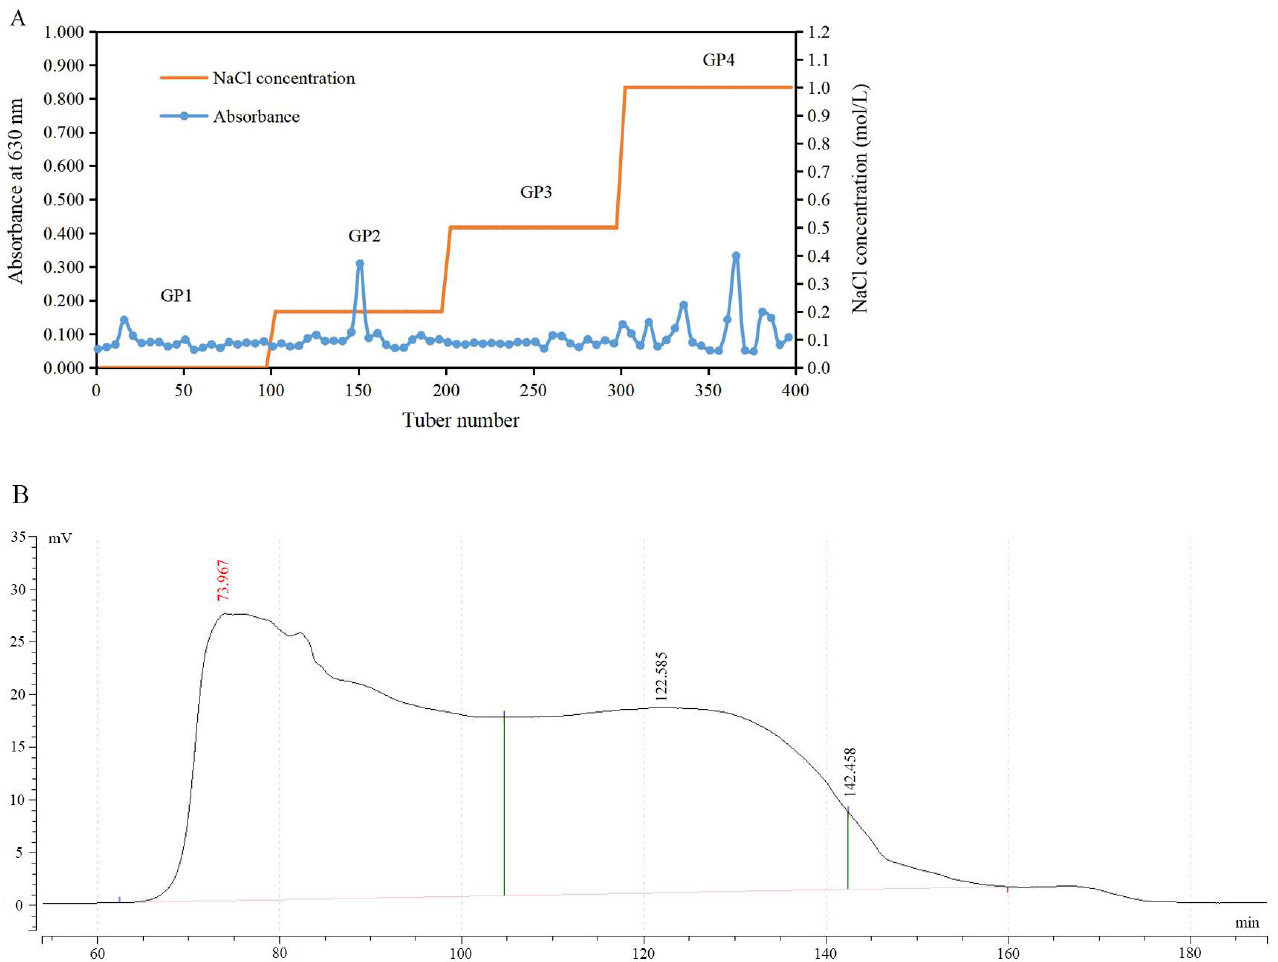
Figure 1. Chromatograms of polysaccharide fractionation. ( A ) Elution curve of crude polysaccharide by ion-exchange chromatography. GP1 — eluted with distilled water (dH 2 O); GP2 — eluted with 0.2 M sodium chloride (NaCl) solution; GP3 — eluted with 0.5 M NaCl solution; GP4 — eluted with 1.0 M NaCl solution. ( B ) Elution curve of GP2 by gel-filtration chromatography.